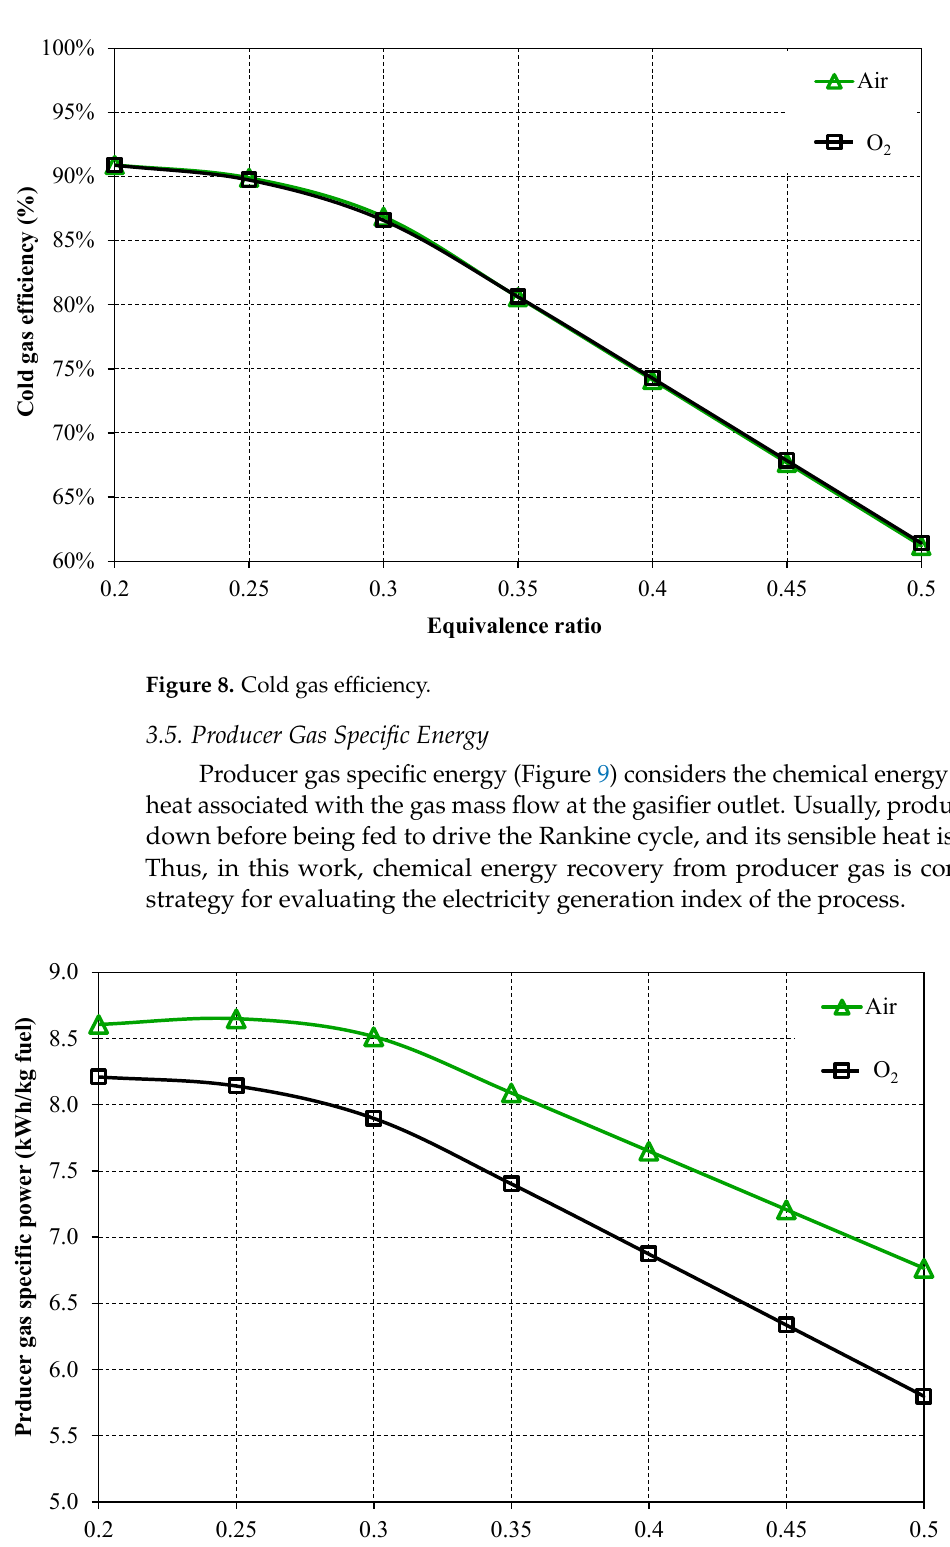
Figure 9. Producer gas specific power.